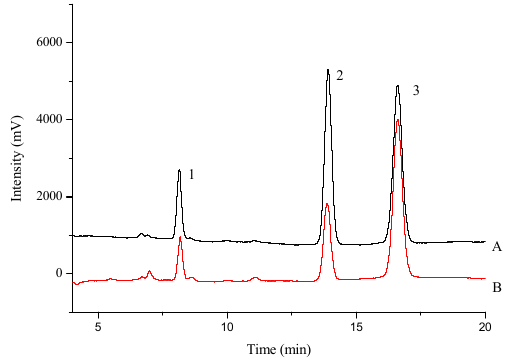
Figure 8. HPLC chromatograms of standard solution ( A ) and sample solution ( B ) 1: 4-nitrocatechol; 2: 4-nitrophenol; 3: phenacetin.